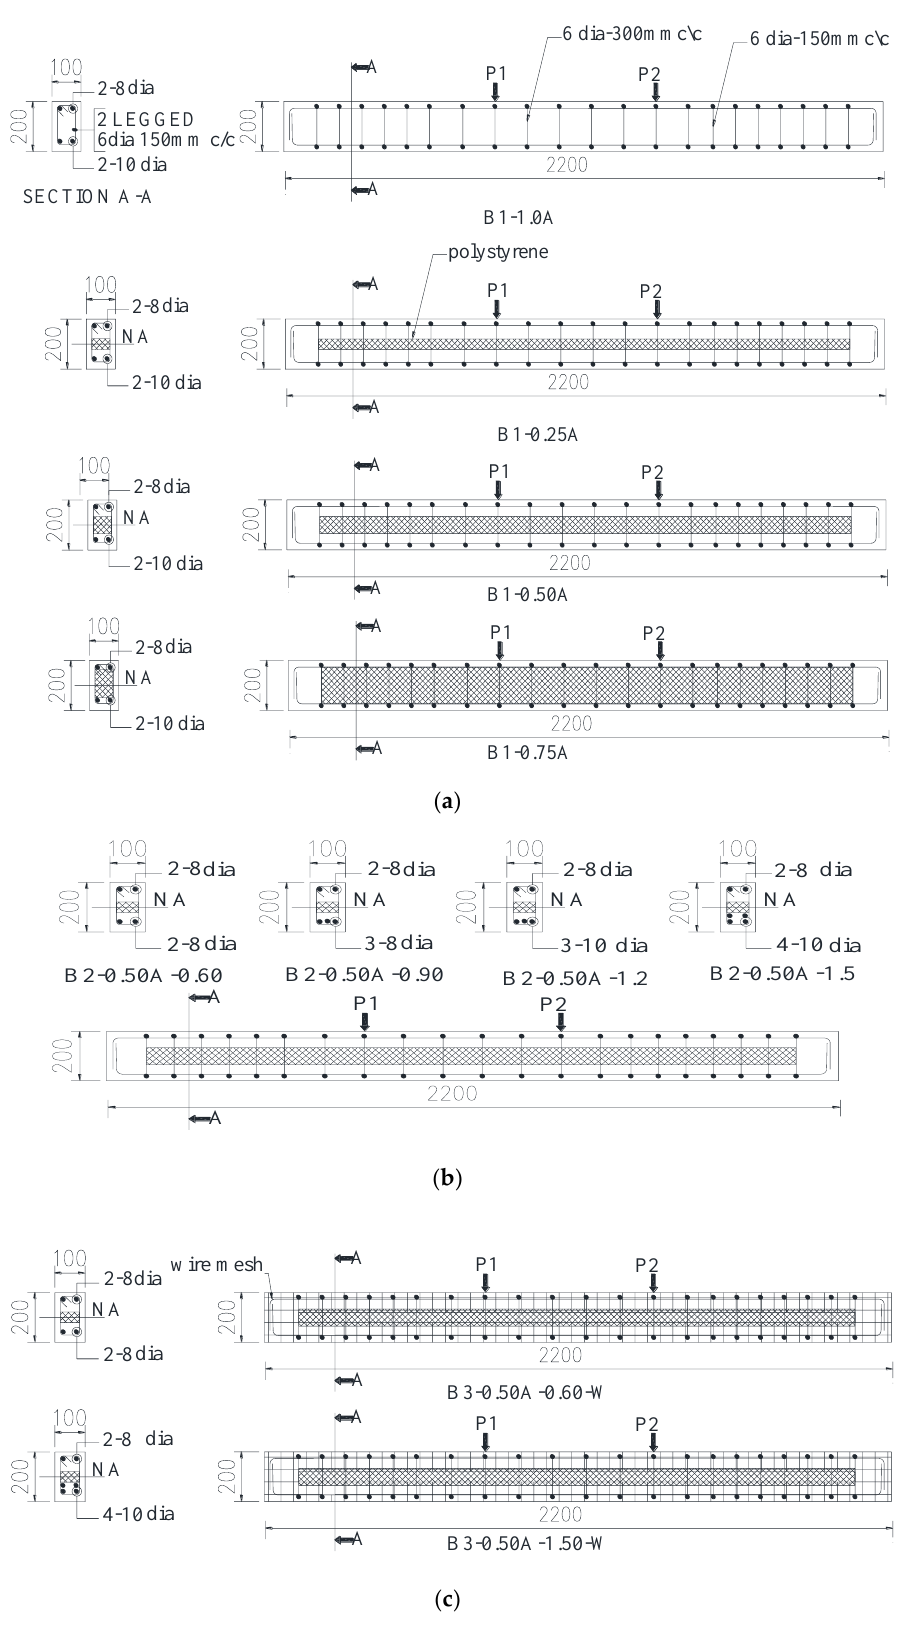
Figure 2. Reinforcement details of the test specimens (All dimensions are in mm). ( a ) Group I: Primary variable—Area of inner core. ( b ) Group II: Primary variable—Percentage of tension reinforcement. ( c ) Group III: Primary variable—Addition of wire